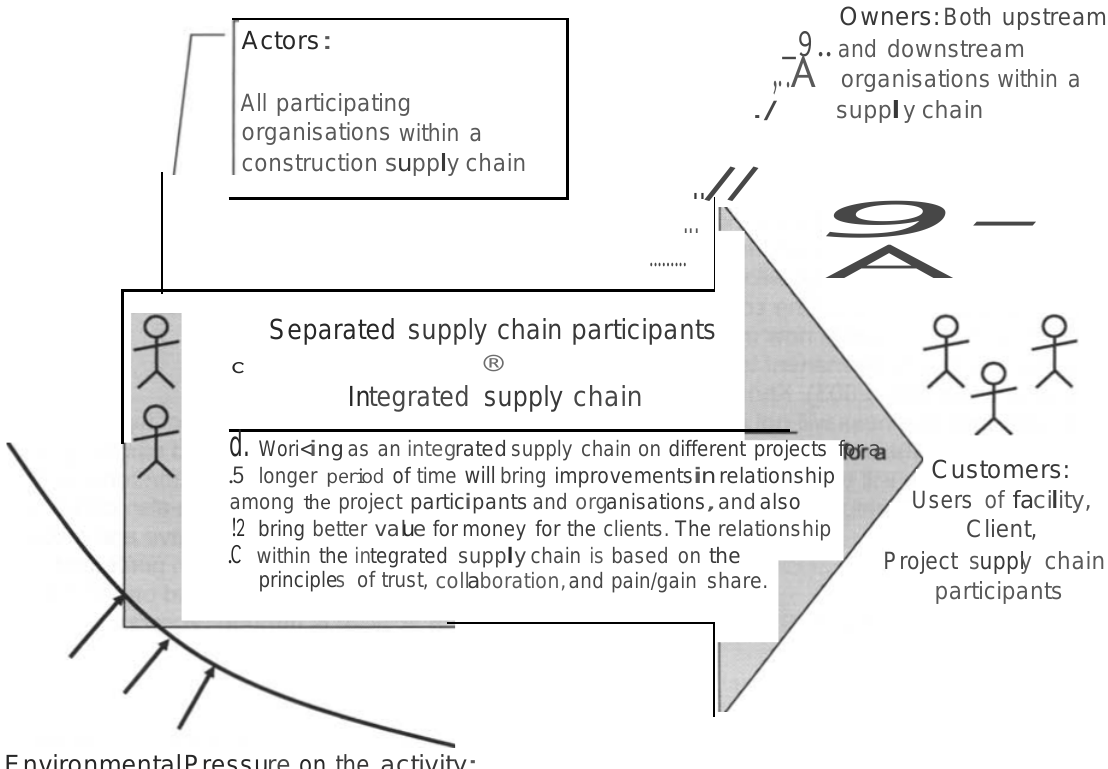
Figure 2: An example of the transformation to integrated supply chain within construction industry